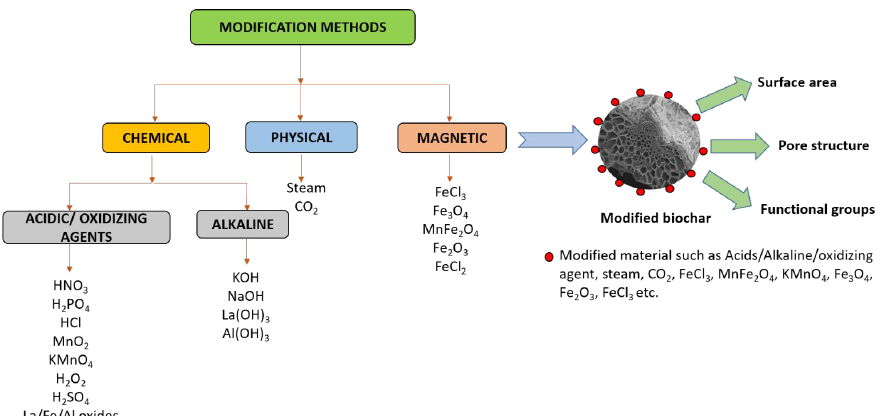
Figure 3. Schematic diagram representing different modification methods of biochar which affect the different properties of biochar, including surface area, pore structure, functional groups on biochar surface, etc.